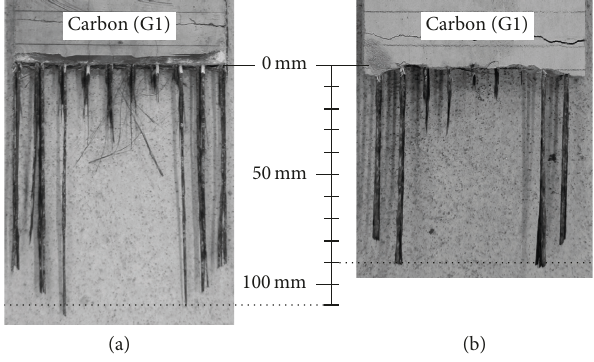
Figure 13: Effect of the manufacturing process and thickness of the matrix on the textile’s development length. (a) Thickness 8 mm, laminated (series 8); (b) thickness 15 mm, sprayed (series 9).